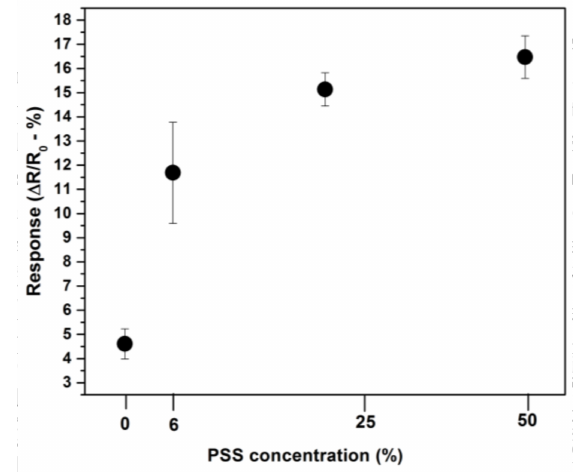
Figure 5. The normalized sensing response of different devices exposed to 100 ppm of NH 3 as a function of poly(styrene sulfonate) (PSS) concentration in: pure ZnO NFs (0% of PSS), ZnO94/PSS6 (6% of PSS), ZnO75/PSS25 (25% of PSS) and ZnO50/PSS50 (50% of PSS)